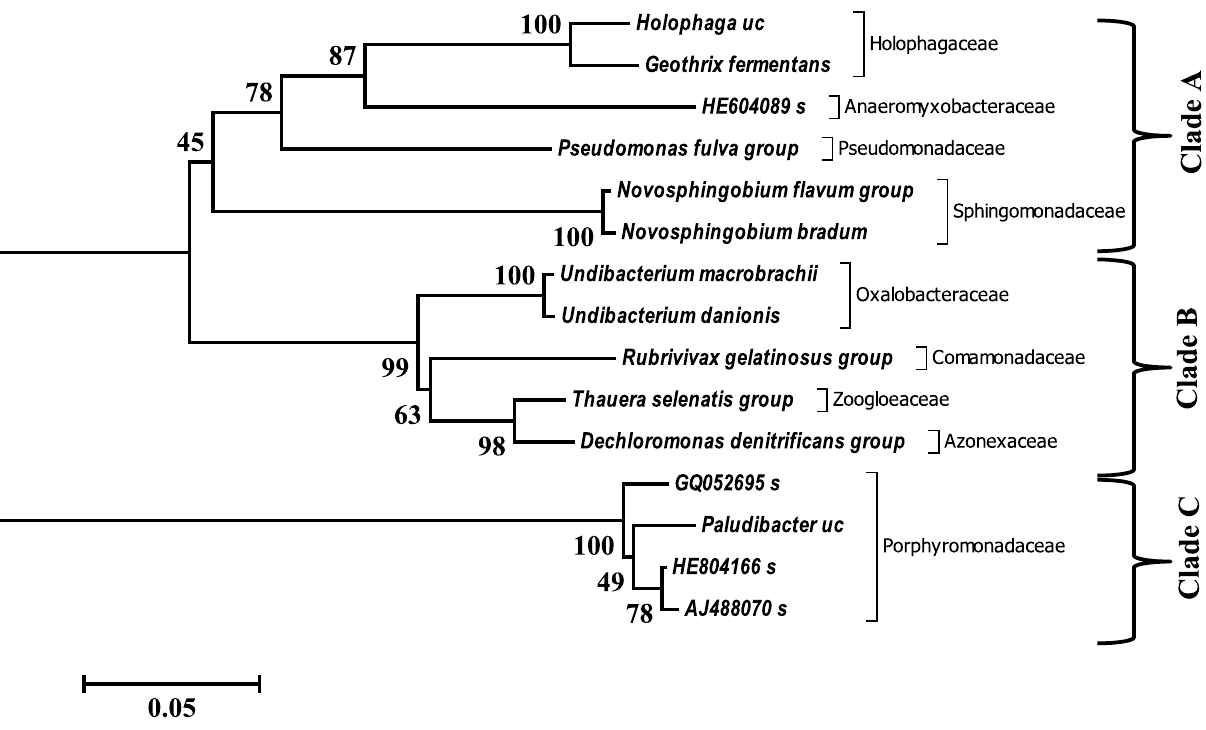
Figure 2. Evolutionary relationships of dominant bacteria taxa in the AMD from Onyeama coal mine. The evolutionary history was inferred using the Neighbor-Joining method. The percentage of replicate trees in which the associated taxa clustered together in the bootstrap test (1000 replicates) is shown next to the branches. The tree was drawn to scale, with branch lengths in the same units as those of the evolutionary distances used to infer the unrooted phylogenetic tree. The evolutionary history was inferred using the Neighbor-Joining method. Evolutionary analyses were conducted in MEGA6, and clades were determined based on monophyletic and polyphyletic